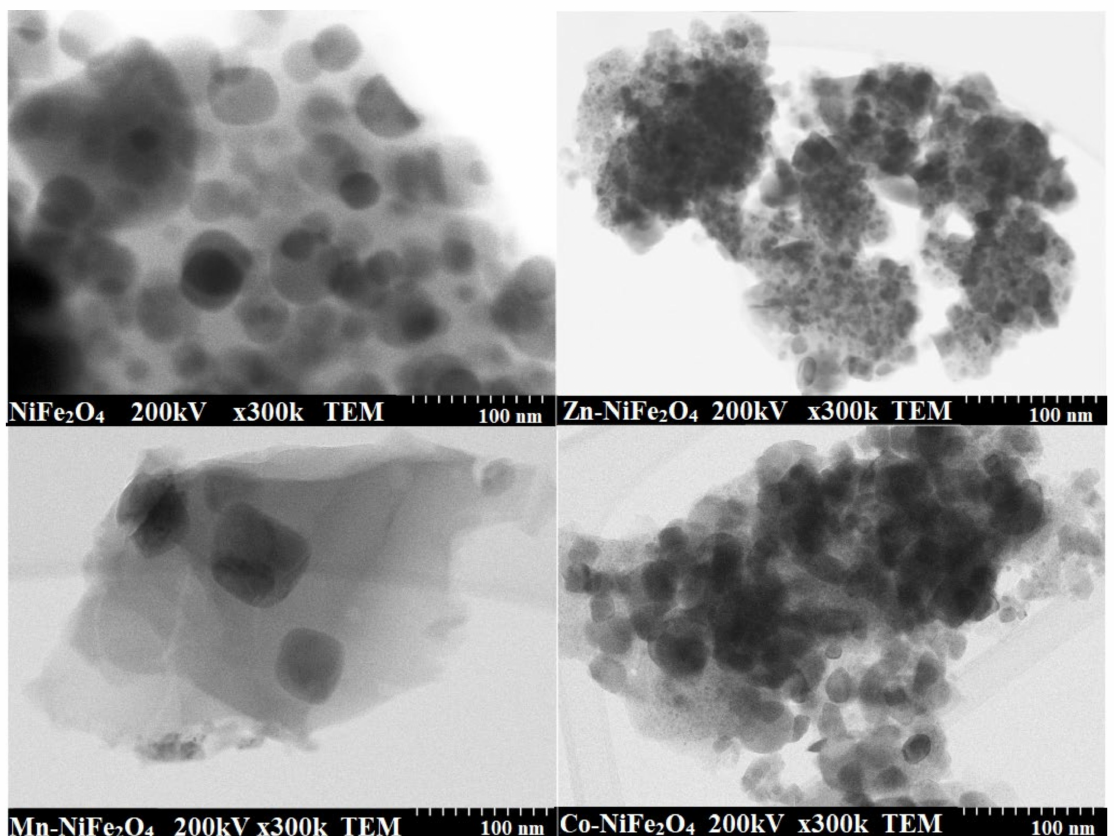
Figure 5. TEM images of virgin and doped NiFe 2 O 4 (Zn-NiFe 2 O 4 , Mn-NiFe 2 O 4 , Co-NiFe 2 O 4 ) NCs annealed at 1000 ◦